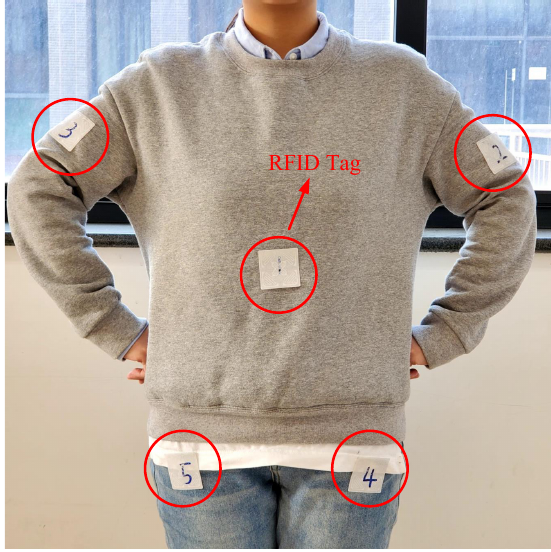
Figure 13. Tag positions.